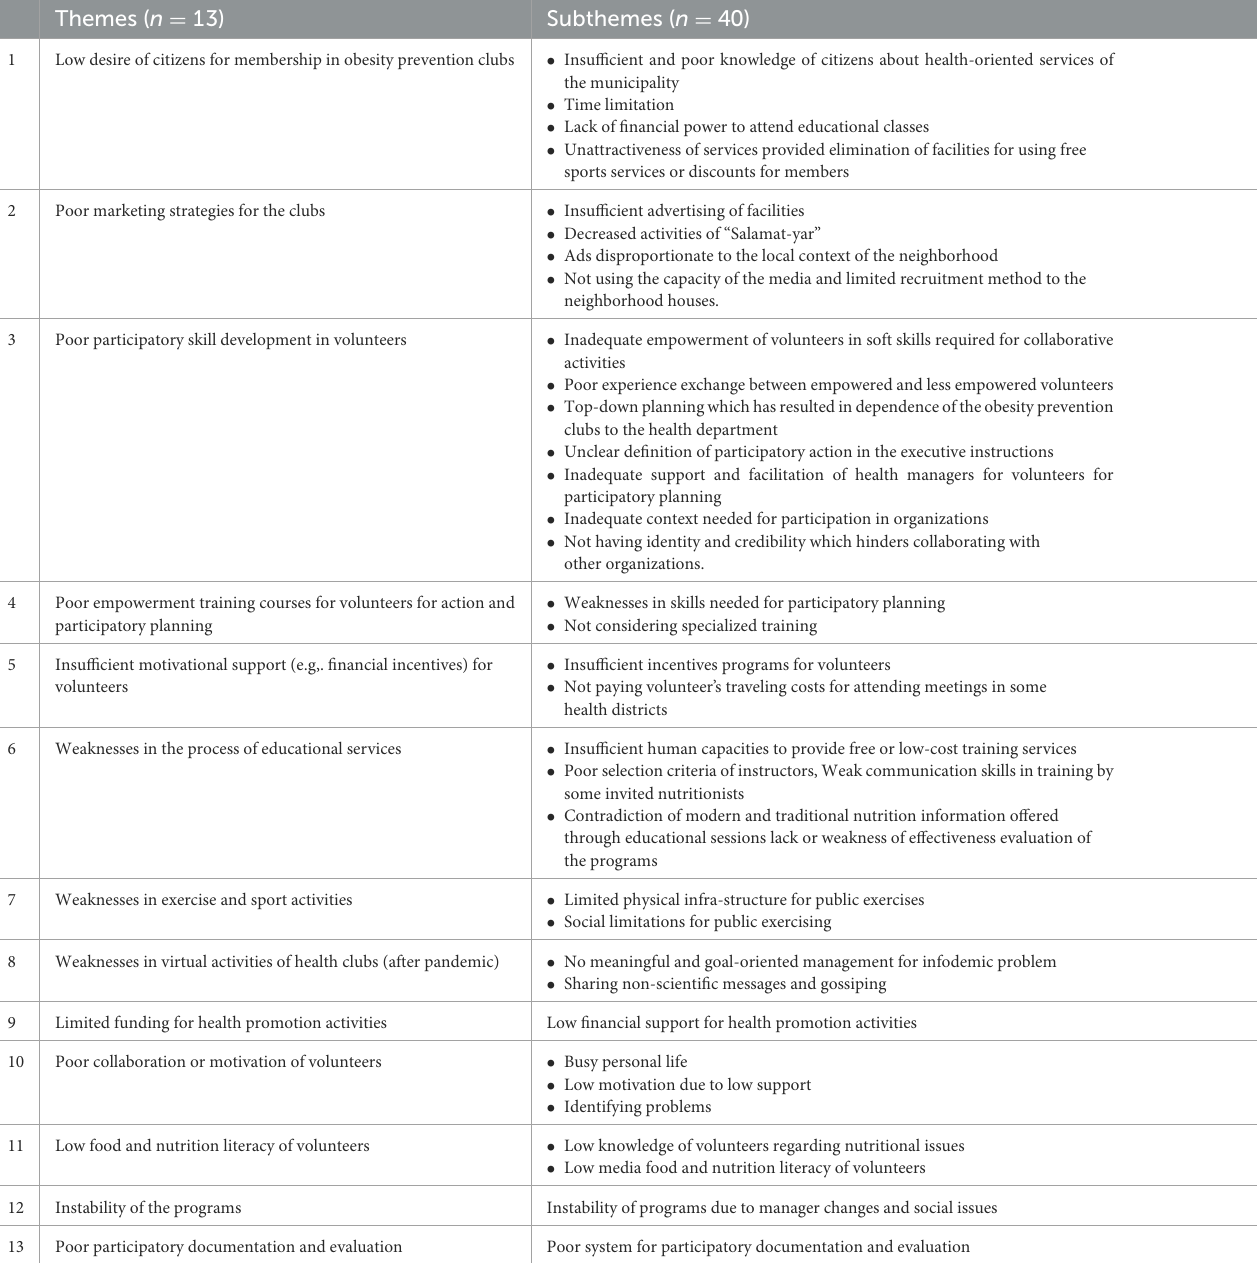
TABLE 2 Themes and sub-themes extracted regarding perceived challenges of stakeholders for implementing obesity prevention clubs’ activities. Themes ( n =